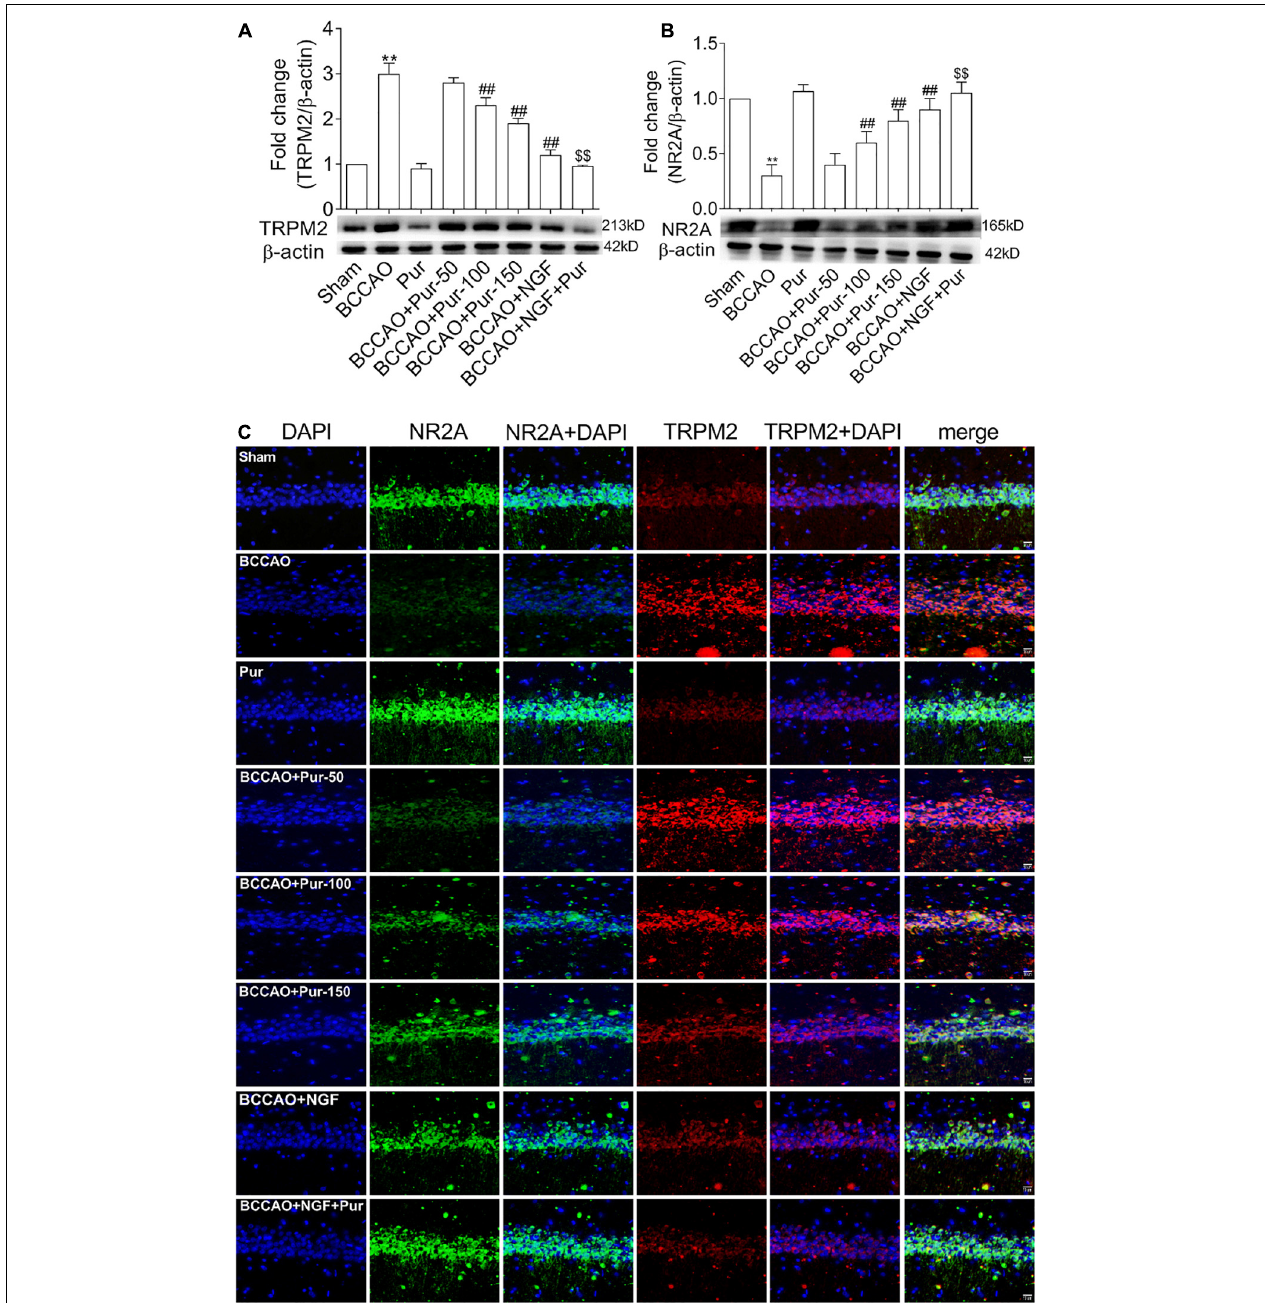
FIGURE 7 | Expression and co-localization of NR2A and transient receptor potential melastatin-related 2 (TRPM2) in the rat hippocampus. (A) Protein amounts of TRPM2 in the hippocampal dorsal CA1 region of rats. (B) Protein amounts of NR2A in the hippocampal dorsal CA1 region of rats. (C) Effects of Pur on NR2A and TRPM2 co-localization in the hippocampal dorsal CA1 region, examined by immunofluorescence double staining. Representative micrographs are shown at × 200. Results were mean ± SEM ( n = 6). ** P < 0.01 vs. Sham; ## P < 0.01 vs. BCCAO; $$ P < 0.01 vs. BCCAO + Pur (150